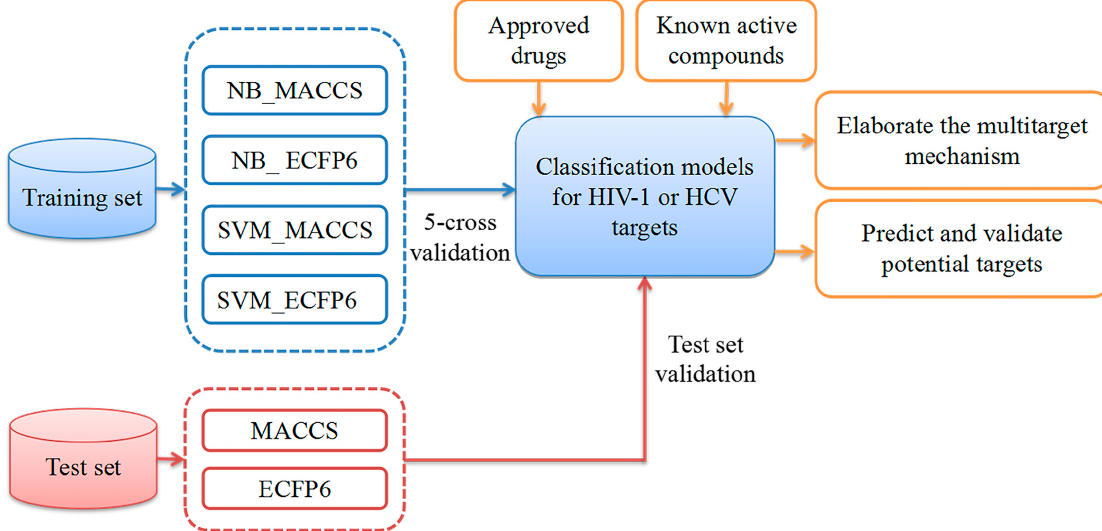
Figure 1. Flowchart showing the process of generating multiple quantitative structure–activity relationships (multiple QSAR) models for human immunodeficiency virus type-1 (HIV-1)/hepatitis C virus (HCV) coinfection (the blue, red and orange objects represent the phases of construction, validation and application of multiple QSAR models, respectively).